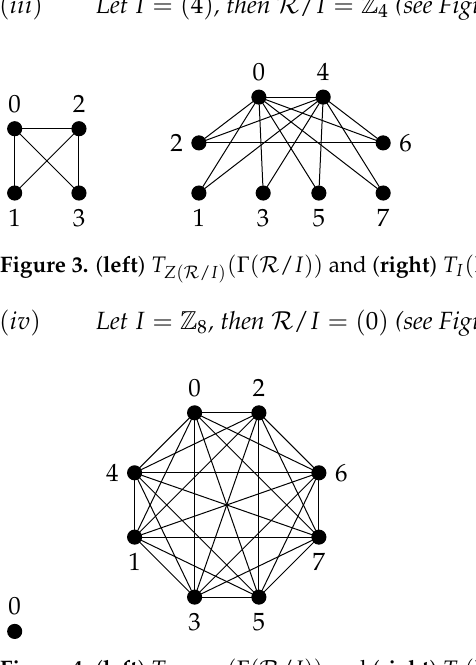
Figure 4. ( left ) T Z ( R / I ) ( Γ ( R / I )) and ( right ) T I ( Γ ( R )) , when R = Z 8 and I = Z 8